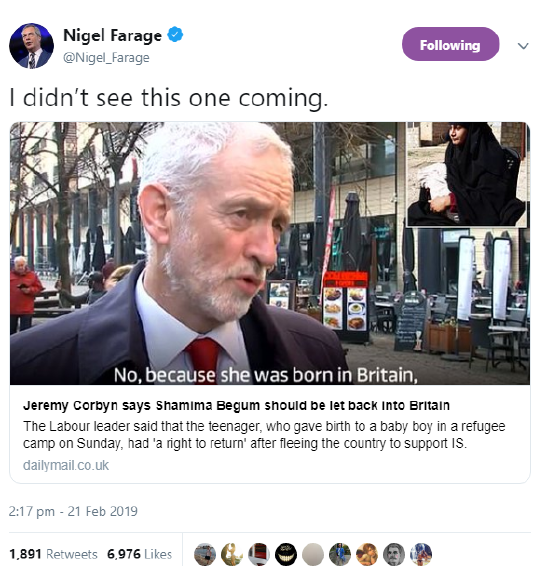
Figure 10. Tweet from Brexit Party leader Nigel Farage, 21 February 2019.